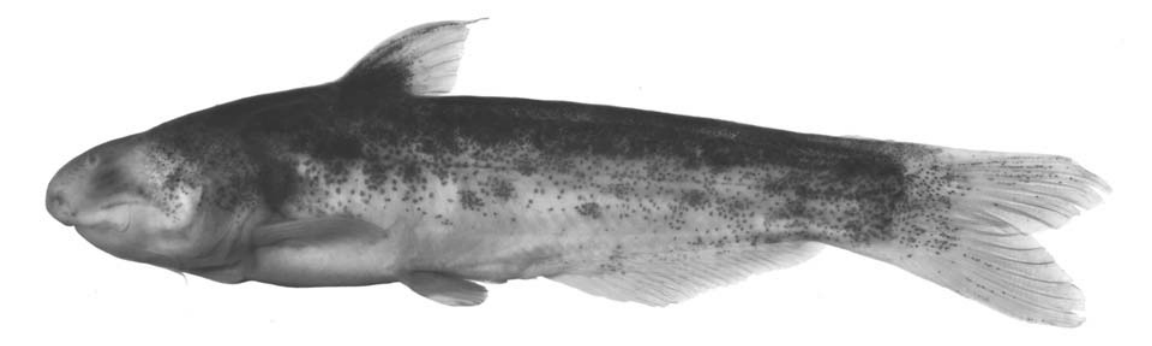
Fig. 13. Cetopsis arcana , new species, holotype, MZUSP 58637, 76 mm SL; Brazil, Goiás, São Domingos, Parque Estadual